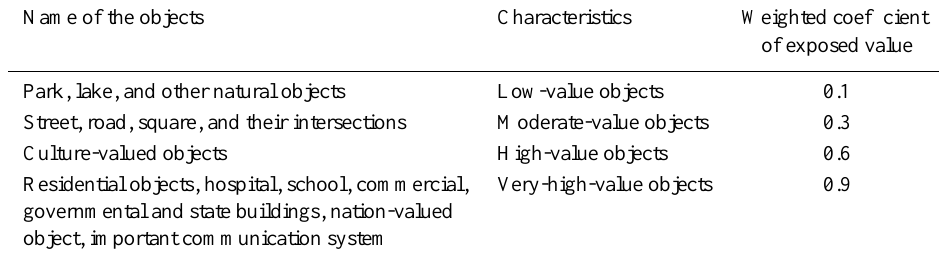
Table 6. Infrastructure exposure